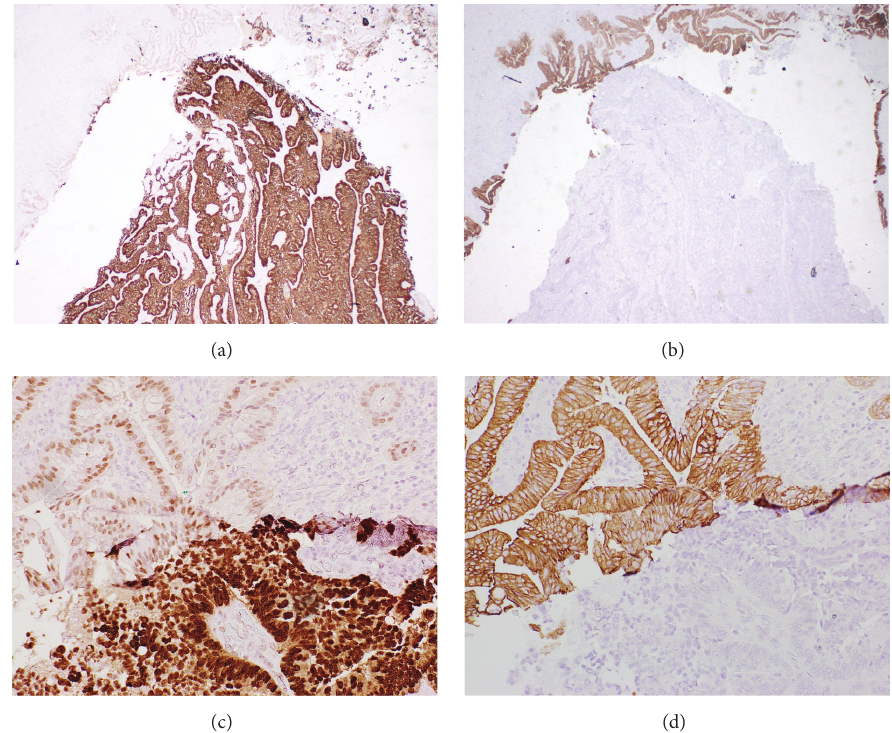
Figure 3: The intrabiliary tumor is positive for CDX2 staining (a and c) and negative for CK7 staining (b and d). CK 7 highlights background bile duct epithelium (b and d). (a and b): × 40; (c and d): ×